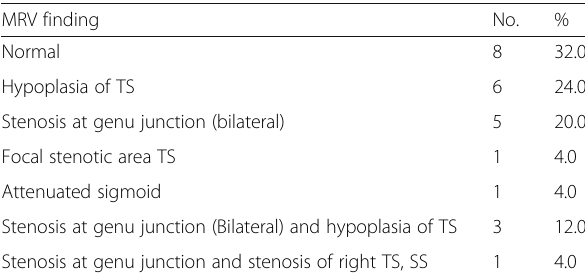
Table 4 Distribution of the studied cases according to MRV finding ( n = 25)